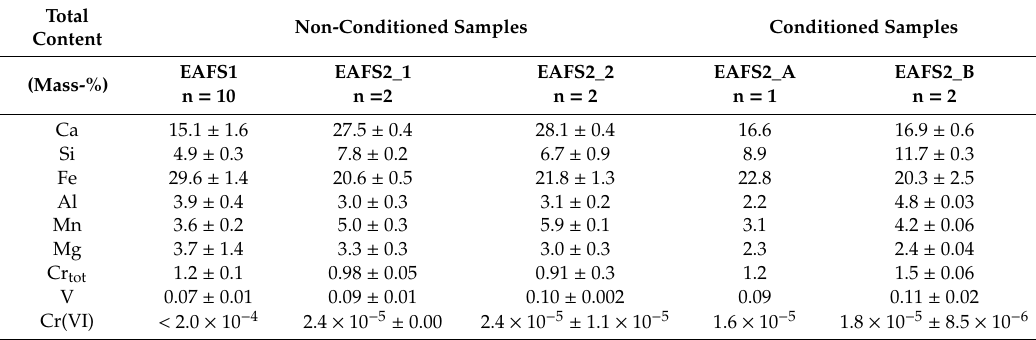
Table 1. Bulk chemical composition (in mass-%) of the investigated EAF slags. Non-conditioned: samples from standard procedure; conditioned: samples with additives (internal steel plant procedure); (s = 1 σ